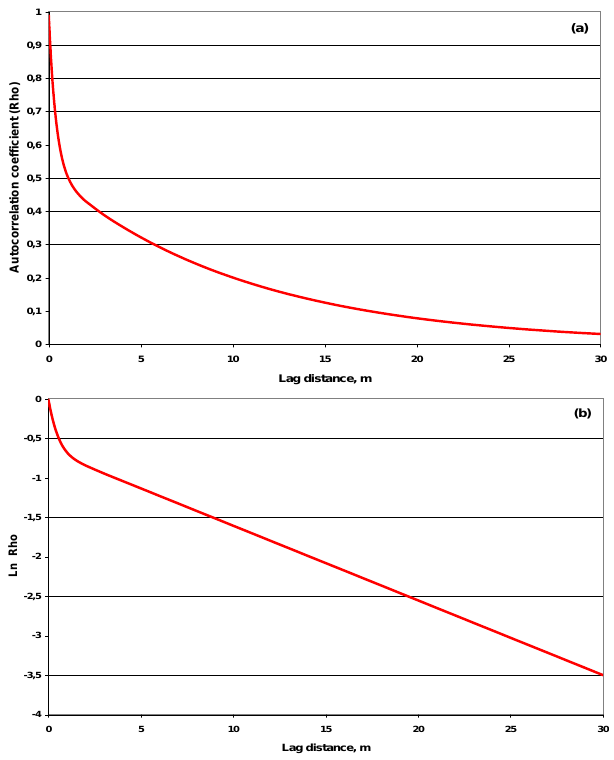
Fig. 12. Hypothetical autocorrelation function consisting of two negative exponential functions to incorporate nugget effect over short lag distances h with h < 2m. Autocorrelation function for nugget effect is superimposed on negative exponential curve for dis- tances h> 2m previously used to filter out the nugget effect in order to retain “signal” of Fig. 1: (a) Graph of Eq. (17); (b) Same graph as in (a) but with logarithmic scale for autocorrelation